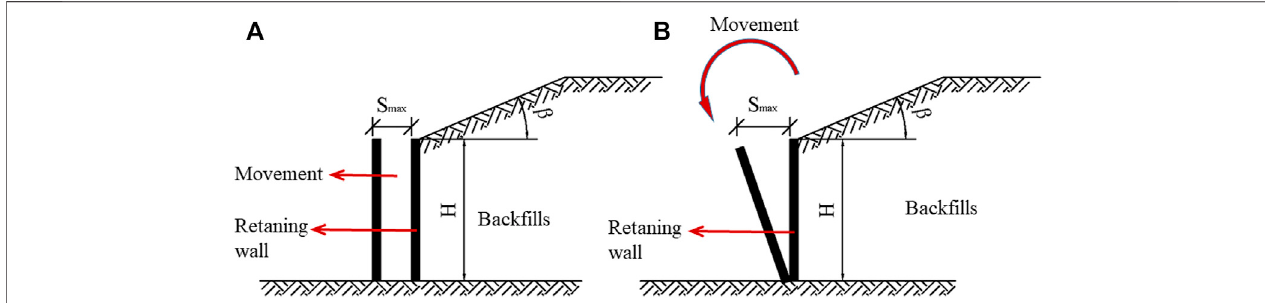
FIGURE 4 | Retaining wall displacement mode. (A) T mode. (B) RB